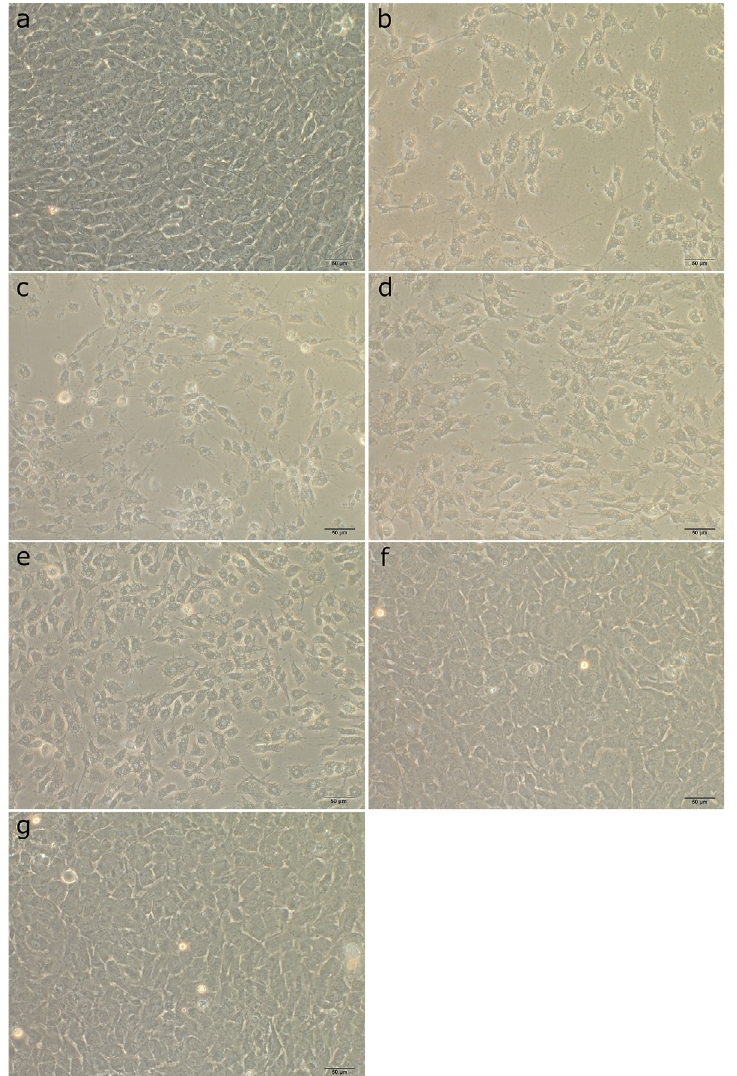
Figure 3- Morphologic changes of RPC-C2A cells after 24 h of exposure to test solutions. (a) Polygonal-shaped cells of the control group. (b-e) Cells treated with SDFX10-4, SDFX10-5, SDFX10-4+5 mM GSH, or SDFX10-4+50 mM GSH, respectively, showed contracted and spheri-cal morphology and increases in intercellular spaces were observed. (f and g) Cells treated with SDFX10-5+5 mM GSH or SDFX10-5+50 mM GSH, respectively, exhibited mostly normal polygo-nal